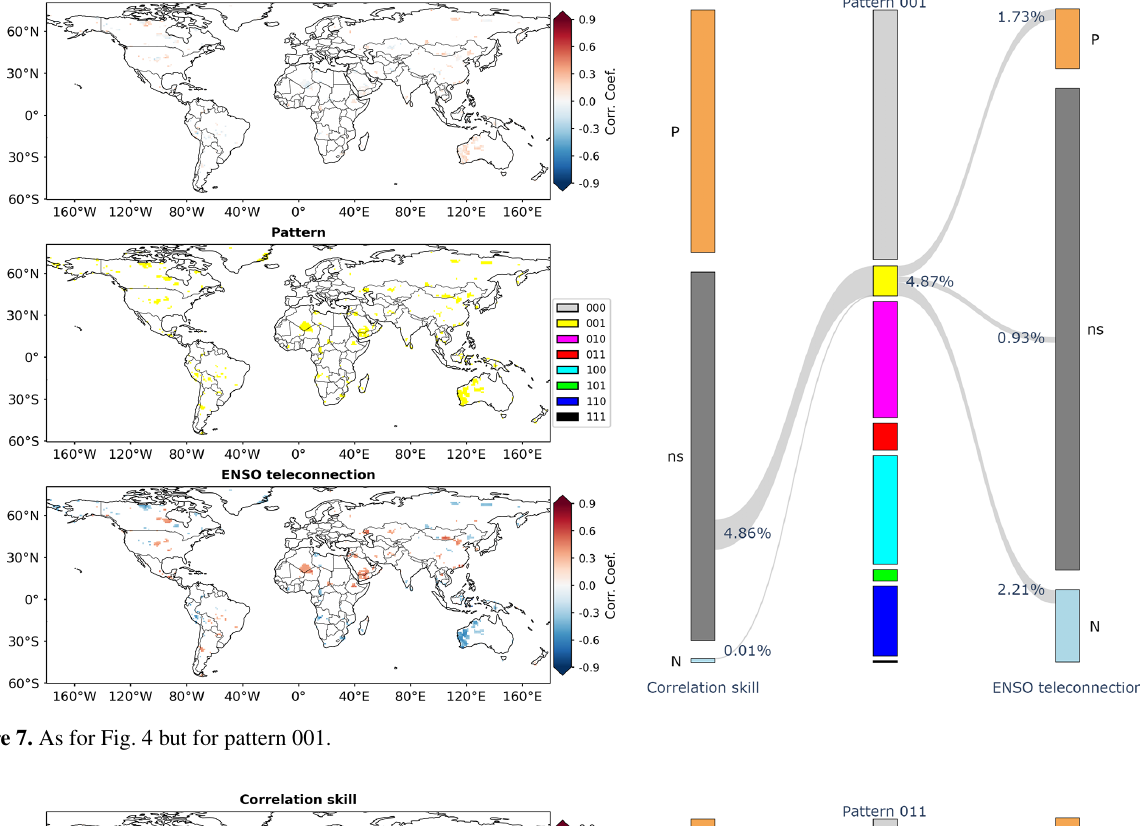
Figure 7. As for Fig. 4 but for pattern 001.